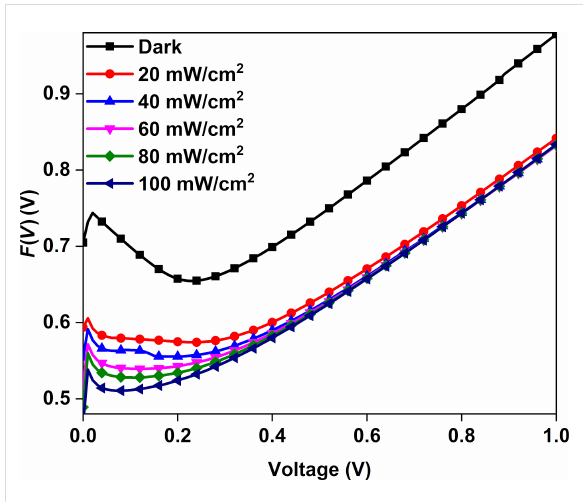
Figure 7: F ( V )– V plots of the Au/CuNiCoS 4 /p-Si photodiode for various illumination power densities.